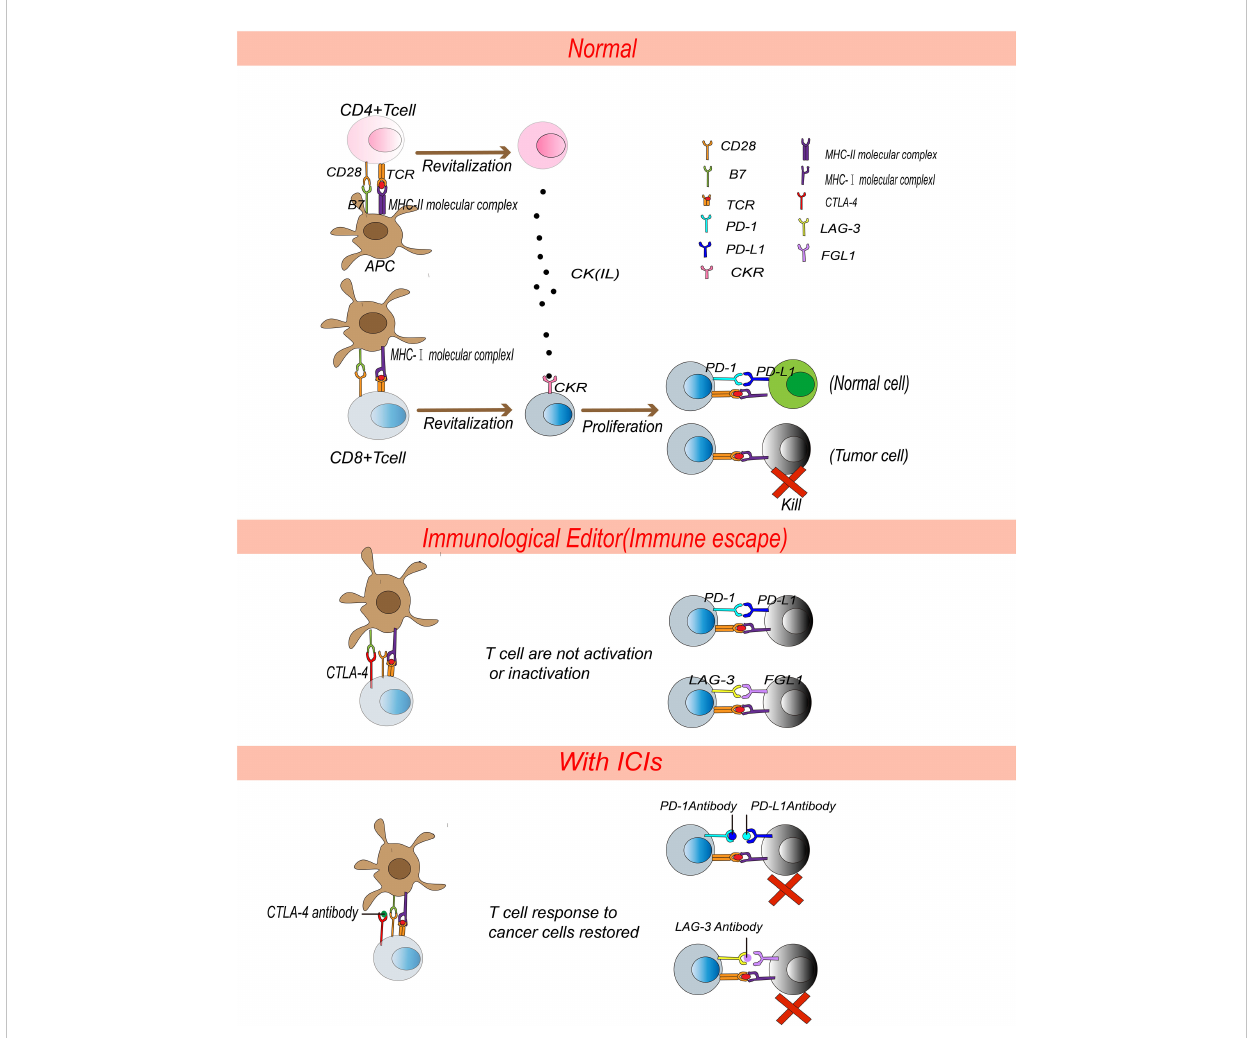
FIGURE 1 Pharmacological mechanism of ICIs. APCs present MHC molecular complexes to TCR on T cells and activate T cells. CD4+ T cells secrete cytokines and stimulate CD8+ T cells proliferation. Activated CD8+ T cells kill tumor cells precisely. Normally, PD-L1 binds to PD-1, FGL-1 binds to LAG-3, inactivating CD8+ T cells and leading to autoimmune tolerance. After immunoediting, tumor cells express PD-L1 and FGL-1 and T cells express CTLA-4 and LAG-3, receptors on T cells bound with ligands on tumor cells or APCs, which will inactivate T cells. ICIs devitalized the PD-1/PD-L1, LAG-3/FGL-1 and CTLA-4/B7 signals and reactivated T cells to kill tumor